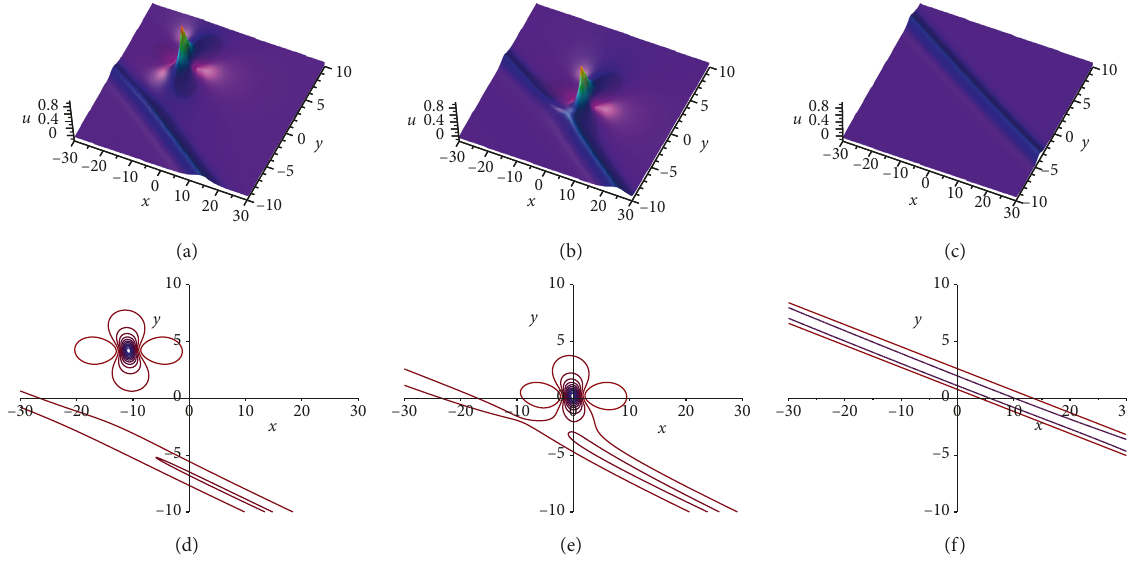
Figure 3: The propagations of the interaction solution between a lump wave and bright soliton (2) with (11) and (13) taking the parameters k a a a a m 0 (cid:28) 1/5, 1 (cid:28) − ( 1/2 ) , 2 (cid:28) 1/2, 3 (cid:28) − ( 3/2 ) , 4 (cid:28) 1/4, and 8 (cid:28) − ( 3/2 ) at different times (a) plots at different times (d) t 20, (e) t 0, and (f) t (cid:28) − (cid:28) (cid:28)